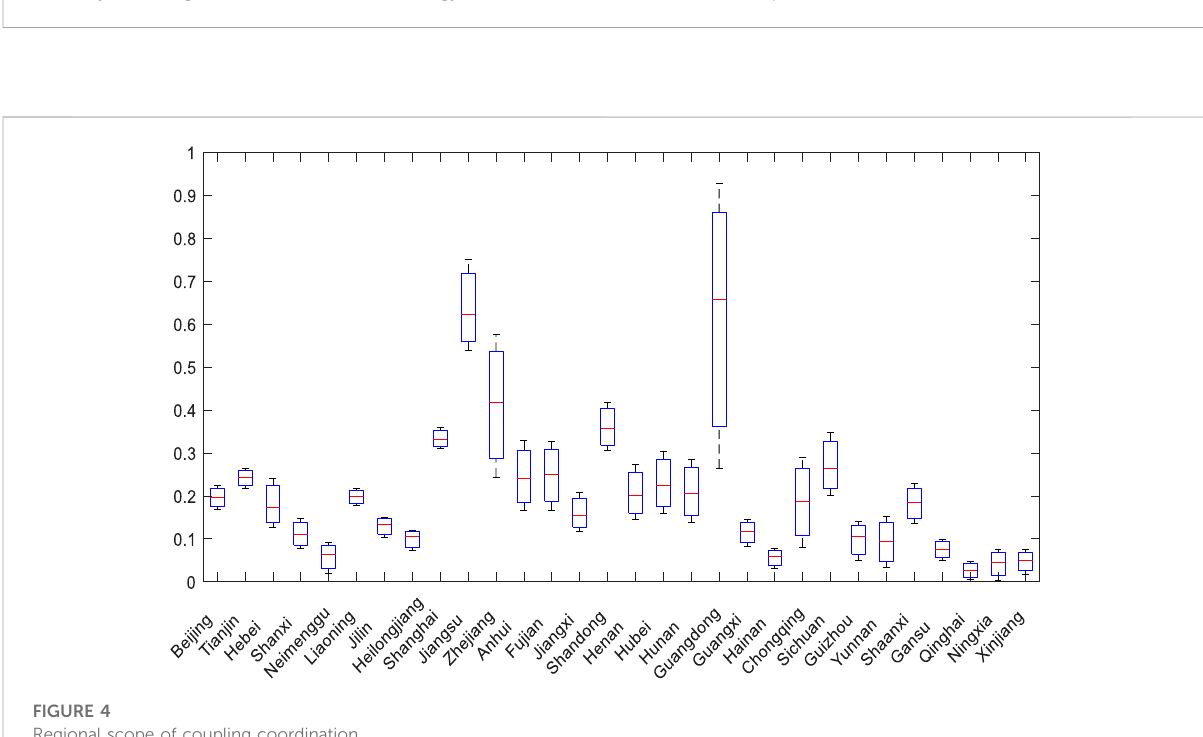
FIGURE 4 Regional scope of coupling